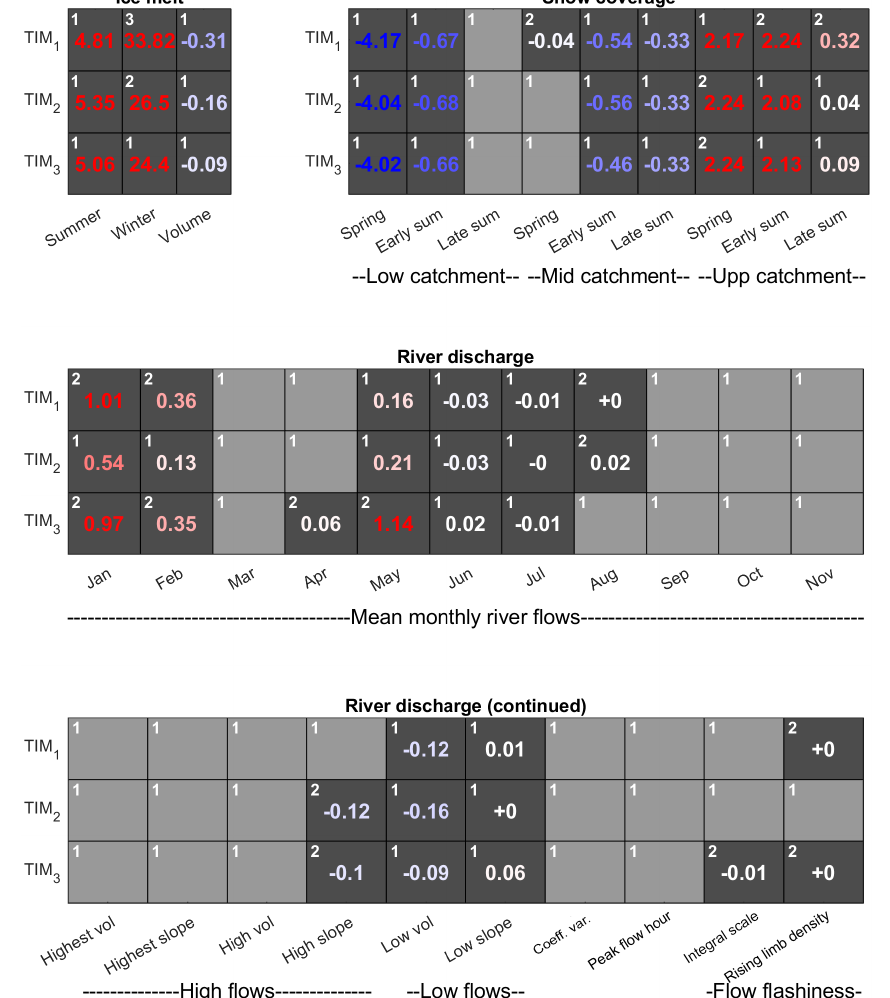
Figure 9. Acceptability scores obtained after calibrating the GHM using the three melt model structures in combination with the ROR 1 run-off-routing model structure. The three GHM configurations were calibrated against ice melt, snow coverage and river discharge signa- tures separately. Light-grey boxes indicate acceptable simulations ( s = 0) and numbered, dark-grey boxes indicate unacceptable simulations coloured blue and red to indicate negative and positive biases respectively. Note that all acceptability scores are rounded to two decimal places. Those non-zero scores that round to zero are accompanied by ± to indicate sign of score. White numbers in the top left of each box indicate relative ranking where acceptability scores are substantially different between the GHM